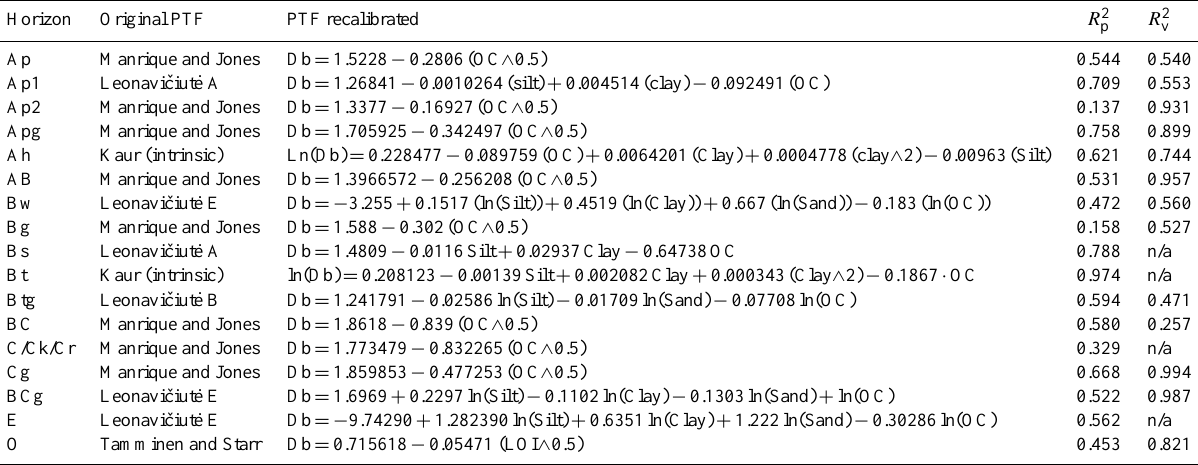
Table 7. Recalibrated pedotransfer functions (PTF) using Irish input data compared to measured bulk density. R 2 p R is the prediction coeffi- cient of determination, R 2 v is the validation coefficient of determination, both based on prediction quality indices (De Vos et al., 2005). ρ b is bulk density (gcm − 3 ). OC is organic